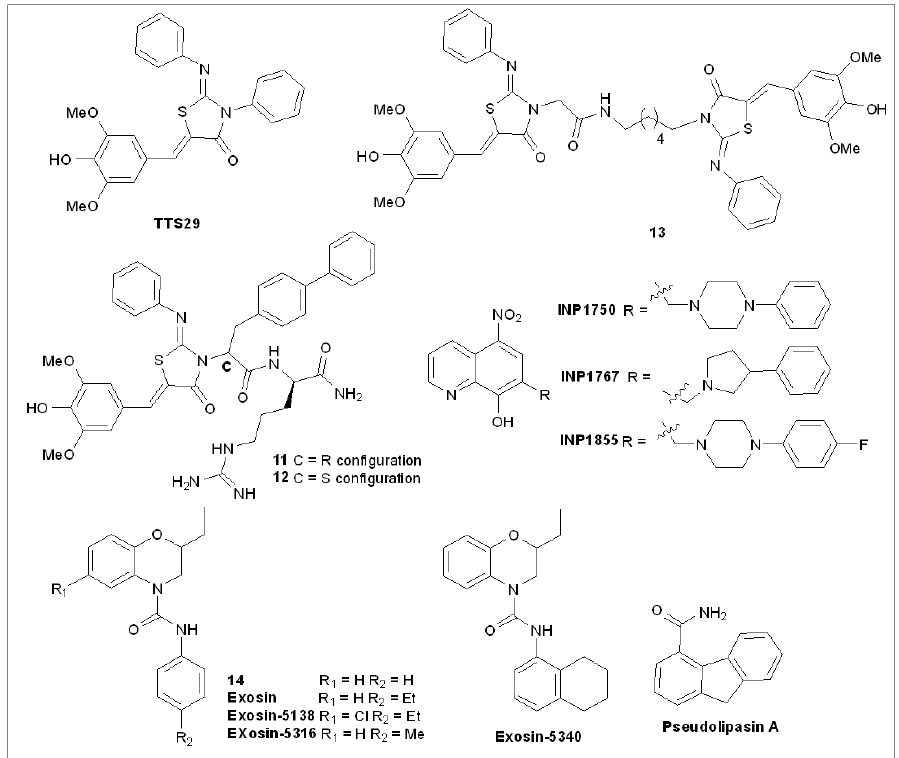
Figure 5. Structures of TTS29, 11 , 12 , 13 , IPN1750, IPN1767, IPN1855, exosin and analogs, and Pseudolipasin A.